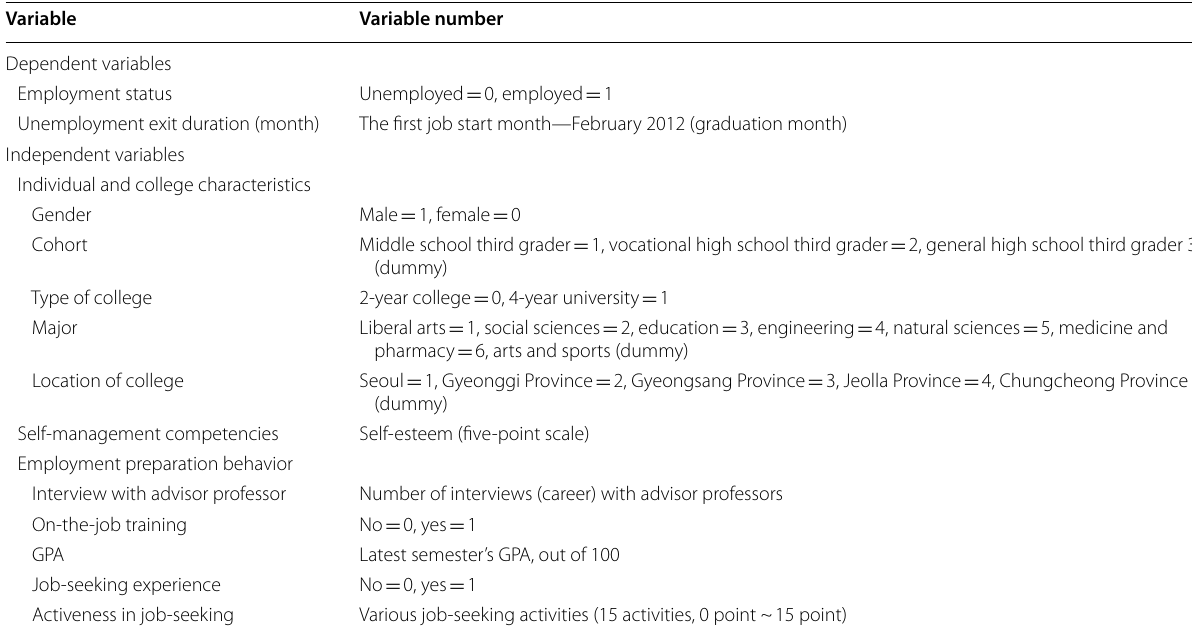
Table 2 The composition and explanation of the variables